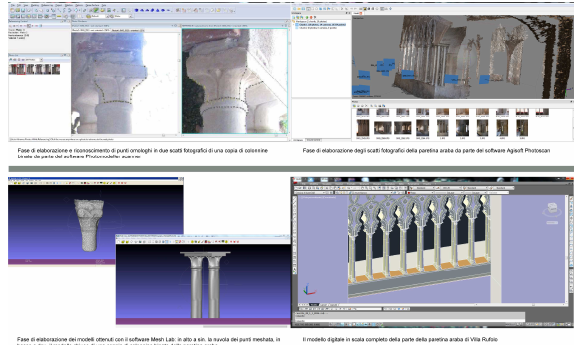
Figure 5. Views from Photogrammetric software for processing